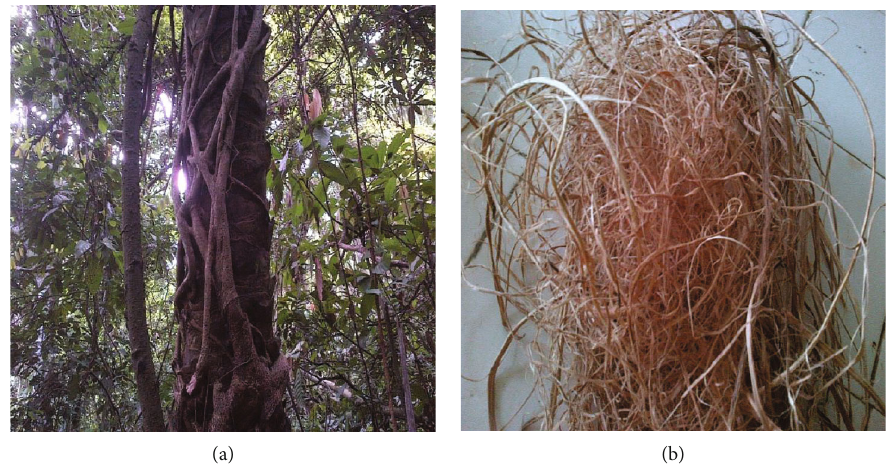
Figure 1: (a) Distribution of Entada mannii fi bers. (b) Strands of Entada mannii fi bers.